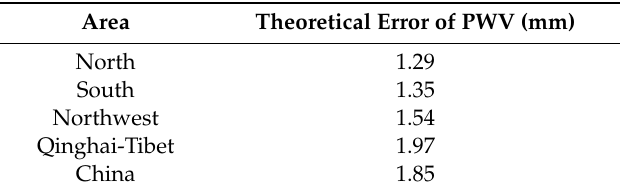
Table 5. Theoretical error of precipitable water vapor (PWV) calculated on the basis of the error propagation law in